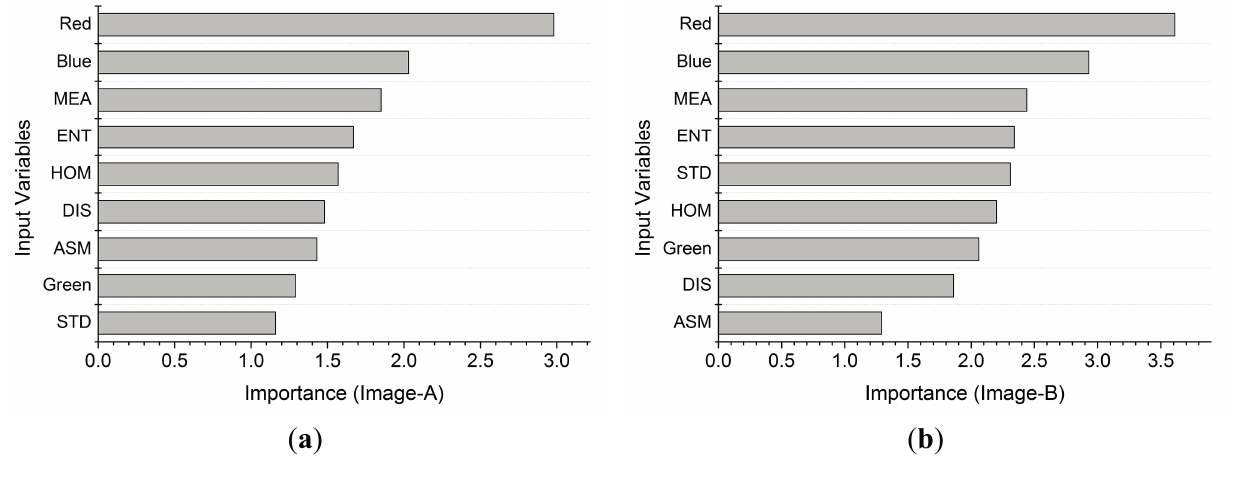
Figure 10. Importance of input variables. ( a ) Image-A; ( b )